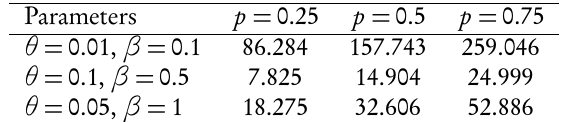
of the GaL distribution. 3